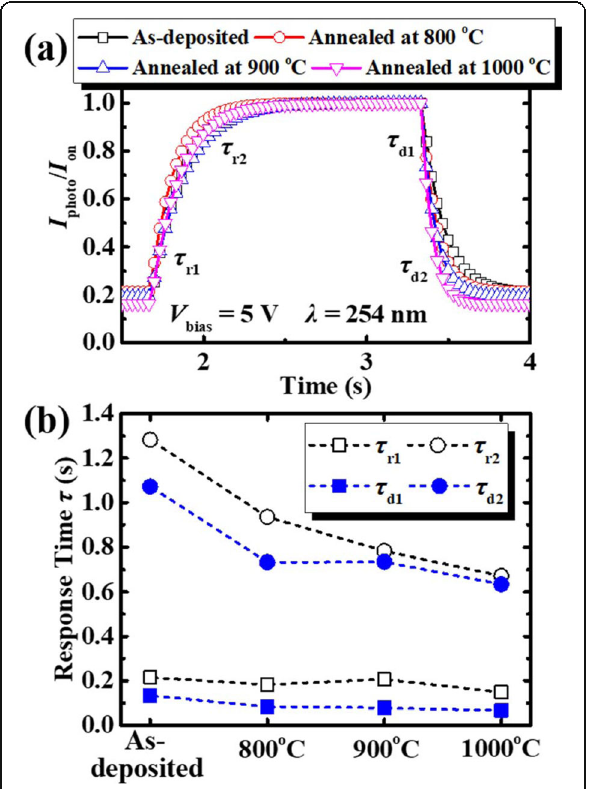
Fig. 6 R versus illumination optical λ for the poly-(Al x Ga 1 – x ) 2 O 3 photodetectors at V bias of 5 V